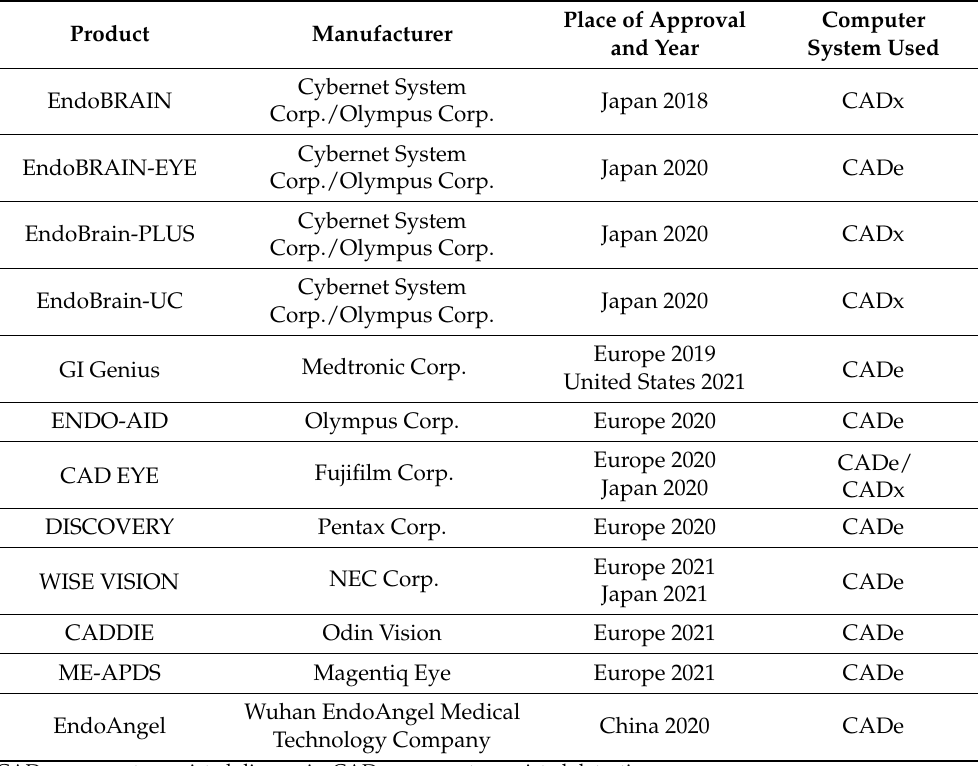
Table 1. Currently approved colonoscopy computer-assisted tools for commercial use (adapted from Taghiakbari et al.,